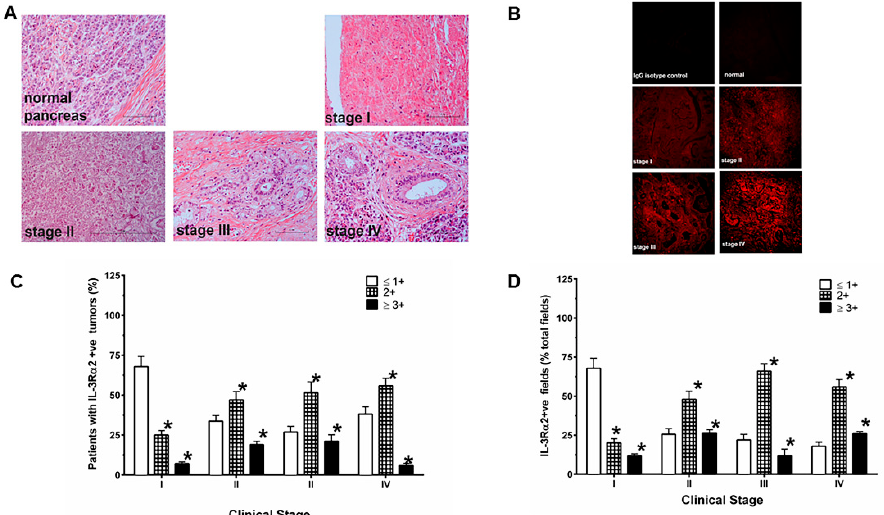
Figure 2. IL-13R α 2 expressing tumor cells in different clinical stages. ( A ) H&E staining of PDAC samples with stage I-IV tumors ( B ) IHC (immunohisto-chemistry) of IL-13R α 2 expression in PDAC with different stages and normal pancreas. ( C ) The extent of IHC staining in PDAC was evaluated at four levels between 0 and 3+ according to the intensity of immunostaining. ( D ) Percent positive fields expressing IL-13R α 2 were counted in samples with different grades. Normal pancreas showed negative staining for IL-13R2e expression. The samples were viewed at 200× magnification. * p = 0.0001.